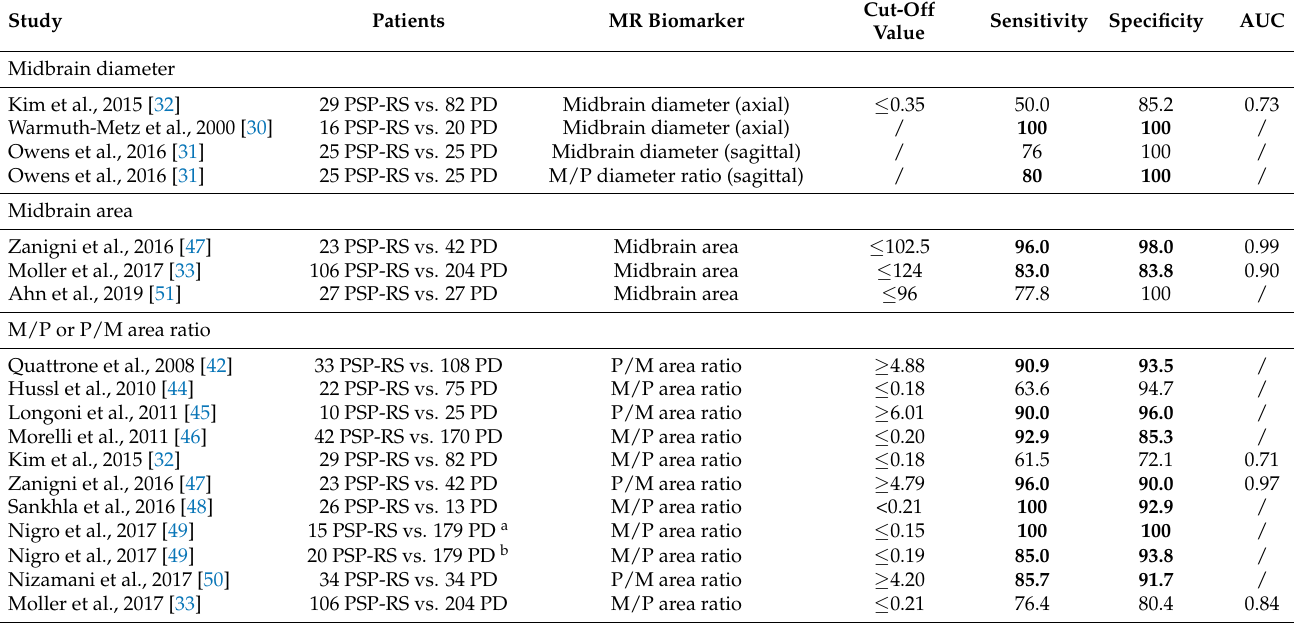
Figure 2. On the left, a midsagittal T1-weighted MR image showing midbrain and pons diameters in a patient with progressive supranuclear palsy. Elliptical regions of interest were placed at their best fit over the midbrain and the pons, and the maximal measurement perpendicular to the major axis of each ellipse was taken (white lines). The midbrain diameter was normalized dividing it by the pons diameter. On the right, a subcallosal axial T1-weighted MR image showing the measurement of the third ventricle width and the internal skull diameter in a patient with progressive supranuclear palsy. Measurements were performed at the level of the third ventricle’s maximum dilatation as the largest left-to-right width between the lateral borders of the ventricle in its central portion. The maximum internal skull diameter (ID) was also measured on the same axial slice. The third ventricle width was normalized dividing it by the ID, and the ratio value was multiplied by 100. Table 1. Studies that assessed the diagnostic performance of brainstem simple manual MR planimetric measurements in distinguishing between progressive supranuclear palsy-Richardson’s syndrome and Parkinson’s